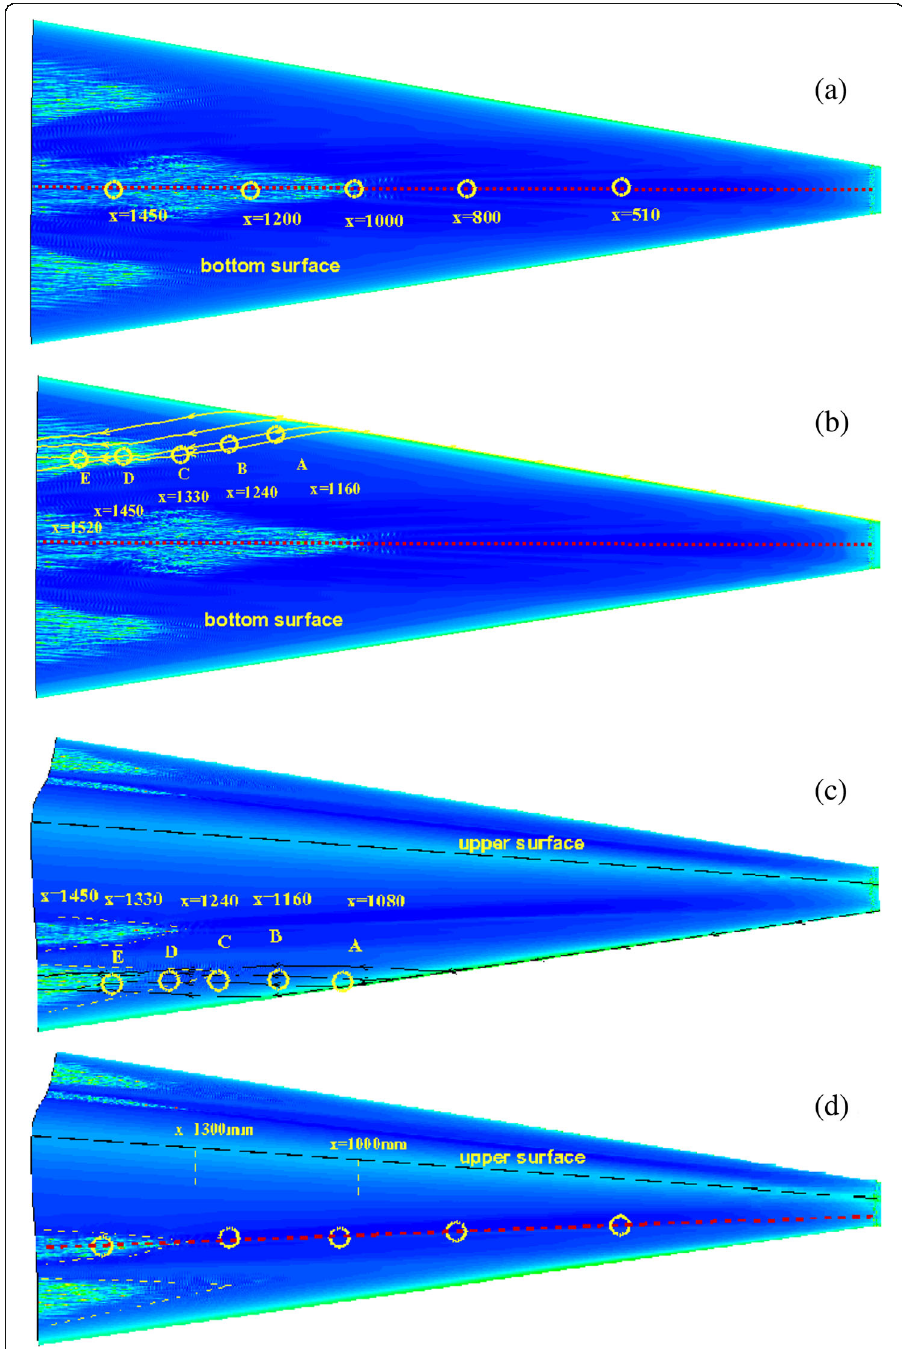
Fig. 15 Schematic of measuring points on the lower surface, ( a ) zone 1, ( b ) zone 2, ( c ) zone 3, ( d ) zone